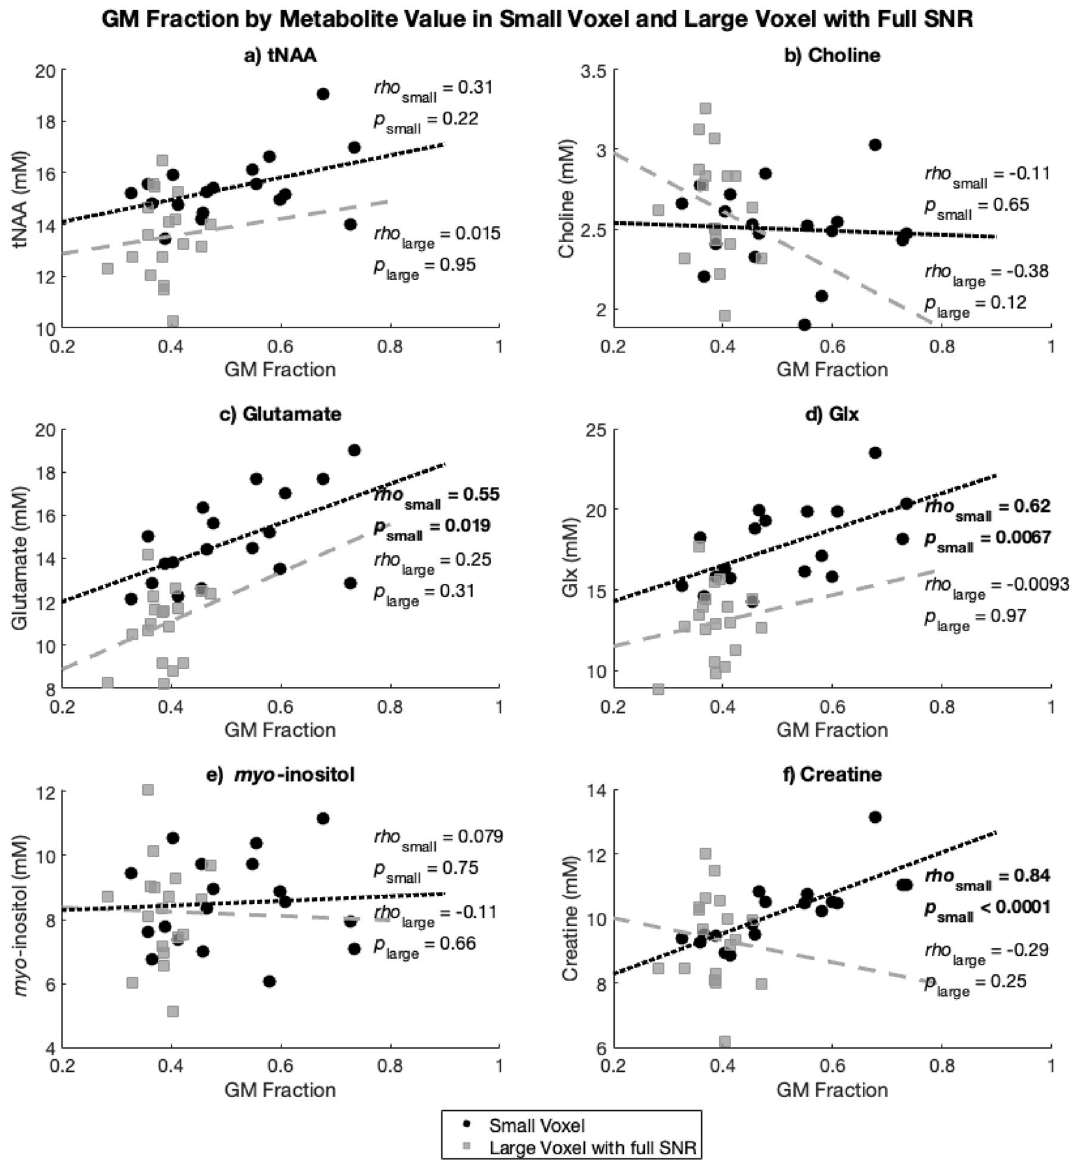
Figure 10. GM fraction by metabolite molal value for the small voxel (circles, with dotted line) and the large voxel with full SNR (squares, dashed line) for ( a ) tNAA, ( b ) Choline, ( c ) Glutamate, ( d ) Glx, ( e ) myo-inositol and ( f )